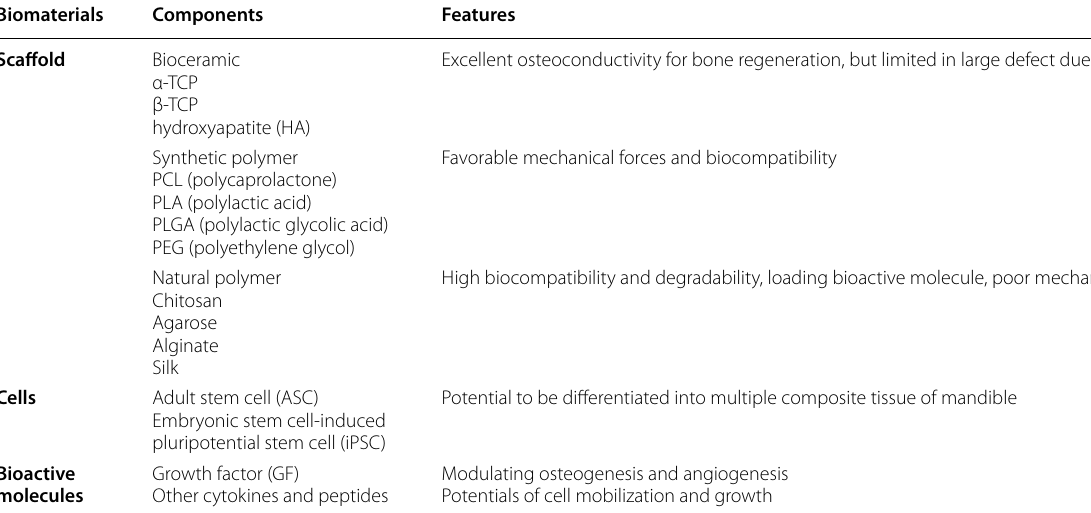
Table 1 Biomaterials for composite reconstruction of mandible